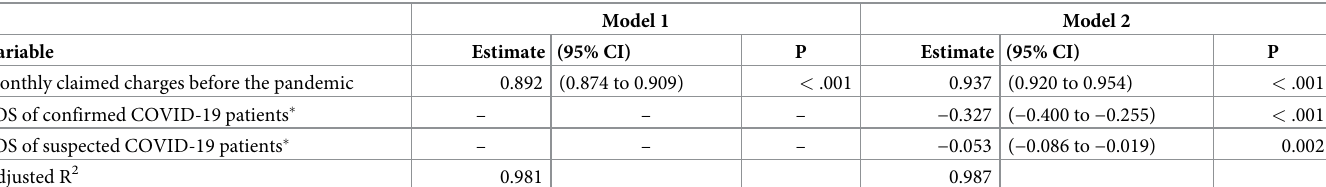
Table 3. Results of the regression